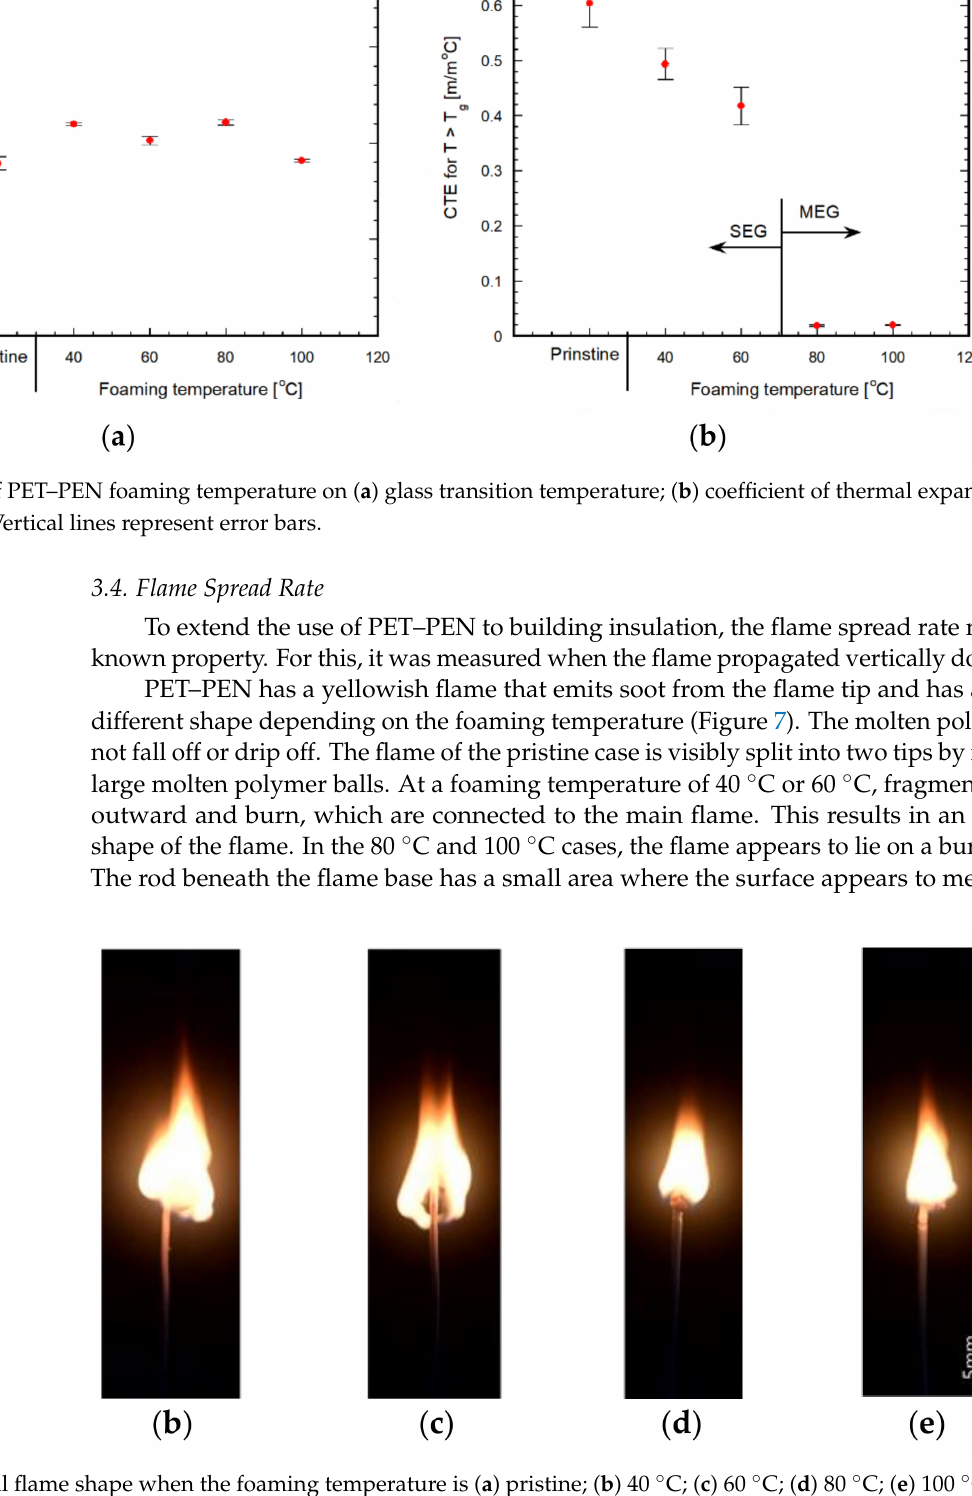
Figure 7. Typical flame shape when the foaming temperature is ( a ) pristine; ( b ) 40 ◦ C; ( c ) 60 ◦ C; ( d ) 80 ◦ C; ( e ) 100 ◦